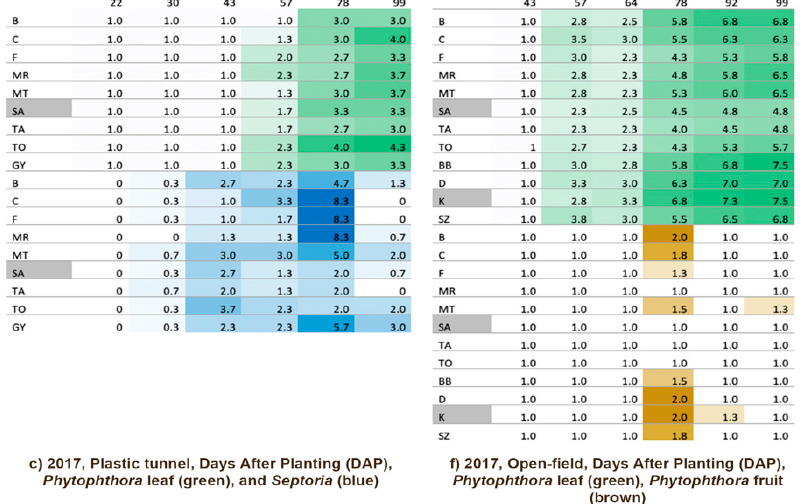
Figure 4. Heat map of Alternaria (red), Phytophthora leaf (green), fruit (brown) and Septoria (blue) infestation average of tomato landraces in 2015 ( a , d ), 2016 ( b , e ) and 2017 ( c , f ), in plastic tunnel and on open field respectively. B: ‘Balatonboglár’; C: ‘Cegléd’; F: ‘Fadd’; GY: ‘Gyöngyös’; MR: ‘Máriapócs’; MT: ‘Mátrafüred’; TA: ‘Tarnaméra’; TO: ‘Tolna megye’. The control variety is SA: ‘San Marzano’. Determinate gene bank items: BB: ‘Balatonboglár’; D: ‘Dány’; SZ: ‘Szentl ő rinckáta’. The control variety is K: ‘Kecskeméti 549’. Control varieties are highlighted with grey background color.